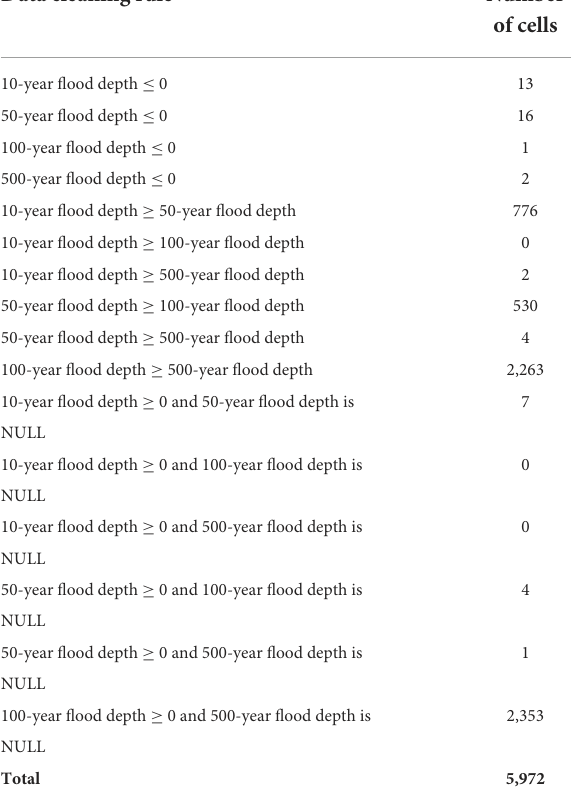
TABLE 2 Number of cells in the study area removed by each data cleaning criterion. Data cleaning